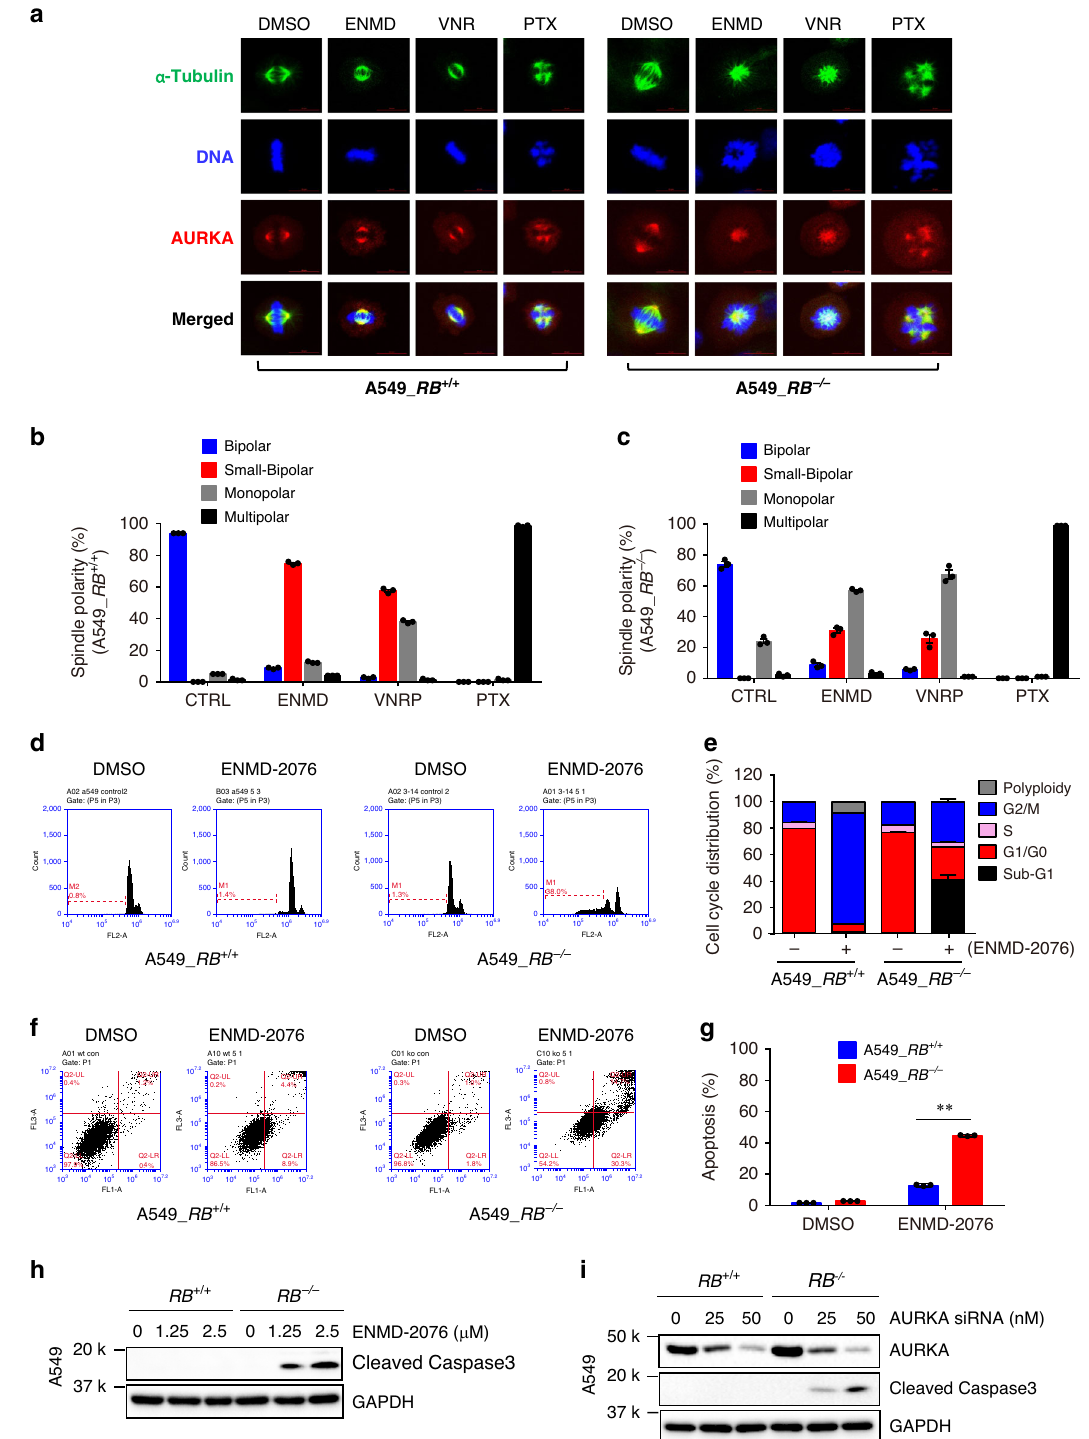
Generation of RB1 − / − cell lines . RB1 CRISPR/Cas9 knockout (KO) plasmid (h, sc-400116) comprising a pool of three plasmids encoding green fl uorescent protein (GFP) and three gRNAs targeting exon 7 and exon 8 of RB1 gene (Supplementary Table 2) and RB1 HDR plasmid (h, sc-400116-HDR) comprising a pool of two plasmids containing a homology-directed DNA repair (HDR) template with a dual selection marker (red fl uorescent protein (RFP) and puromycin resistance gene) were purchased from Santa Cruz Biotechnology (Dallas, TX). RB1 CRISPR/Cas9 KO plasmid and RB1 HDR plasmid were cotransfected into A549 and HCC827 cells using Lipofectamine 3000 (Thermo Fisher Scienti fi c). The RB1 − / − clones were selected with RFP fl uorescence and puromycin antibiotics (1 μ